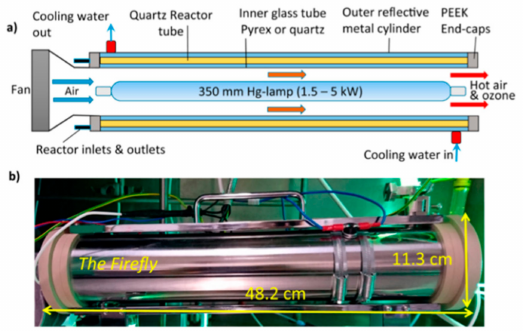
Figure 5. Representations of the firefly photoreactor. ( a ) Diagram of reactor; ( b ) Firefly reactor in operation; (reproduced with permission from [31])